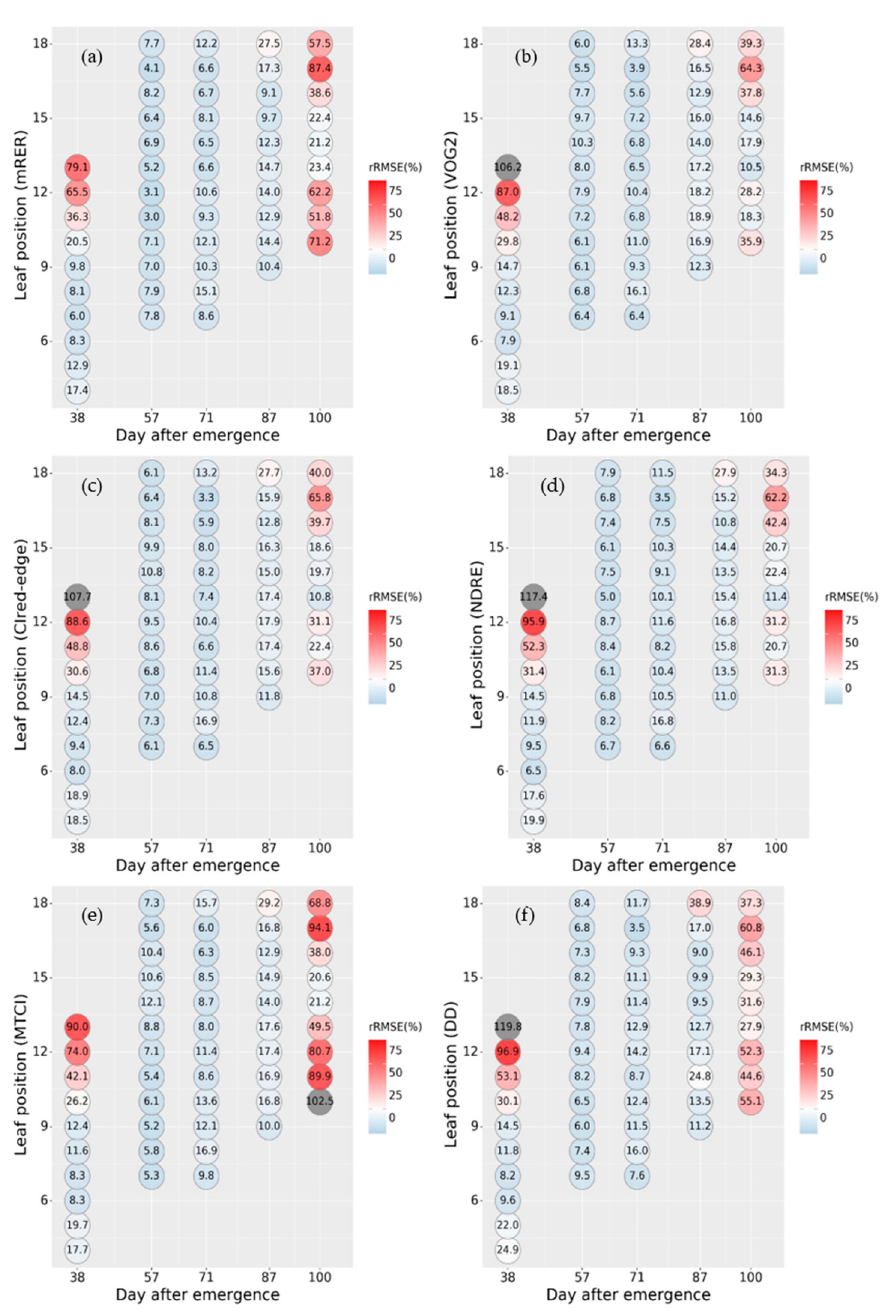
Figure 4. Relationship between LCC and six selected vegetation indices (VIs): ( a ) modified red-edge ratio (mRER), ( b ) Vogelman red edge index 2 (VOG2), ( c ) red edge chlorophyll index (CI red-edge ), ( d ) normalized difference red edge index (NDRE), ( e ) MERIS terrestrial chlorophyll index (MTCI), and ( f ) double difference index (DD). Linear models were built using the 2020 modeling dataset. Correlation coefficients and p -values are shown above each scatterplot, and the distributions of VI and LCC values are shown as histograms at the top and side of each graph, respectively.